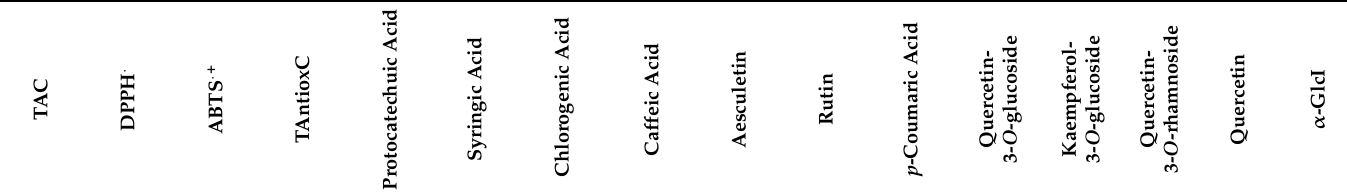
Table 6. Pearson’s correlation between studied traits in M. germanica , P. spinosa and C. monogyna fruit ethanolic